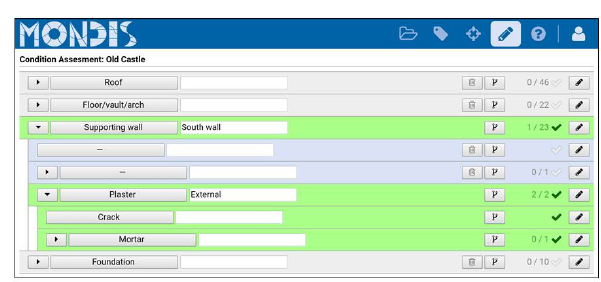
Figure 9. Building components, material and damage